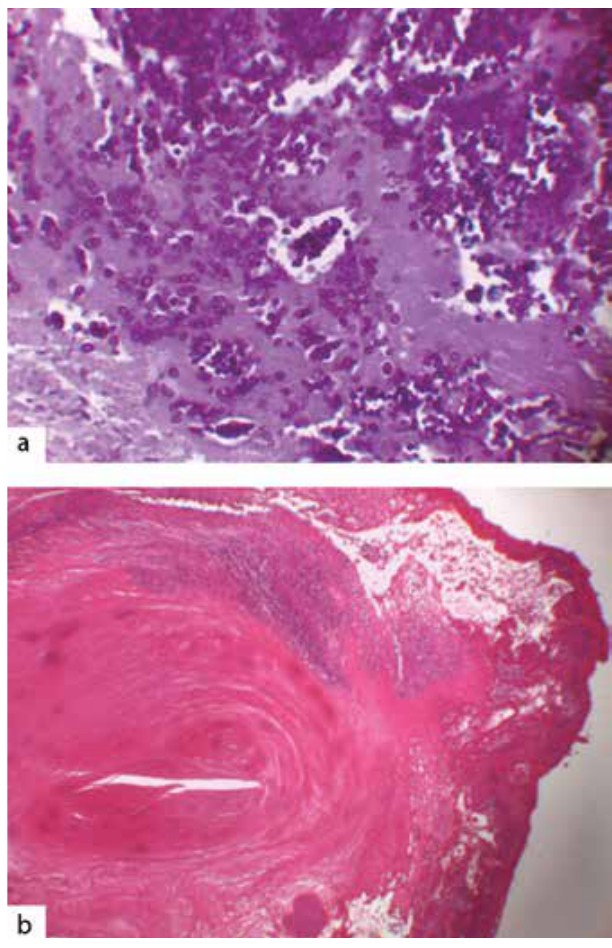
Fig. 2. Histological examination of the infected mitral valve with vegetations showing pre-existing fibrosis and infected